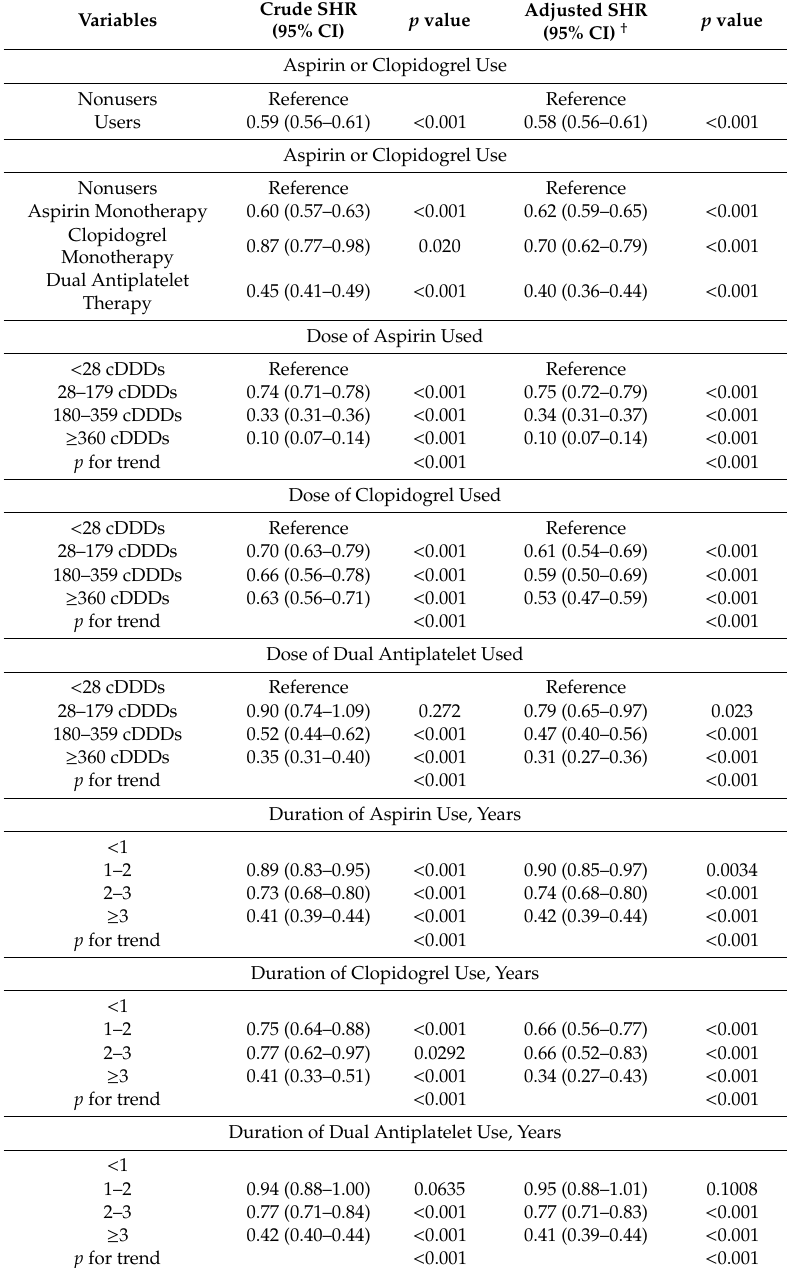
Table 5. Incidence rate and subhazard ratio of CRC in patients using aspirin and clopidogrel or not, using competing risks regression